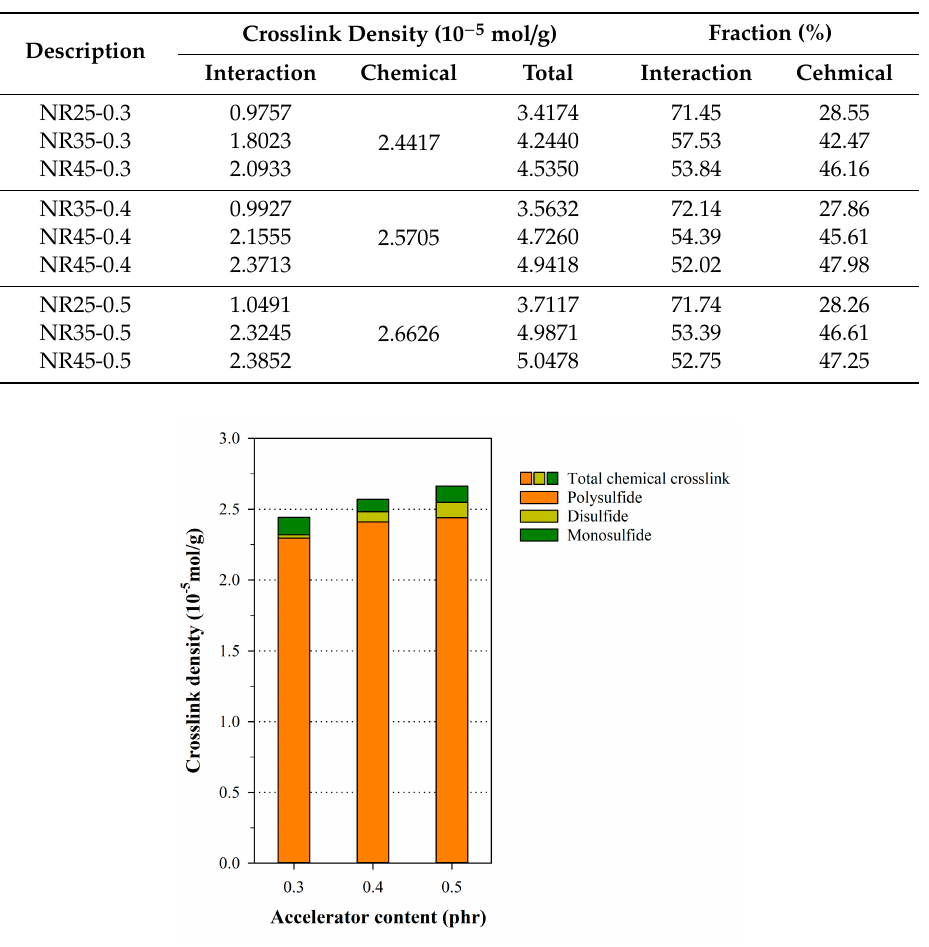
Figure 4. Chemical crosslink structure of the NR sample with varying accelerator content.